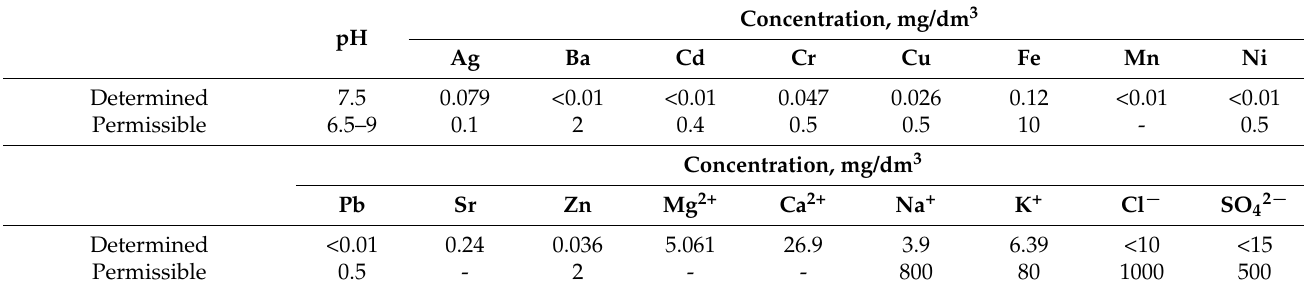
Table 3. Composition of water extracts of the tested clays and permissible values given in [46].